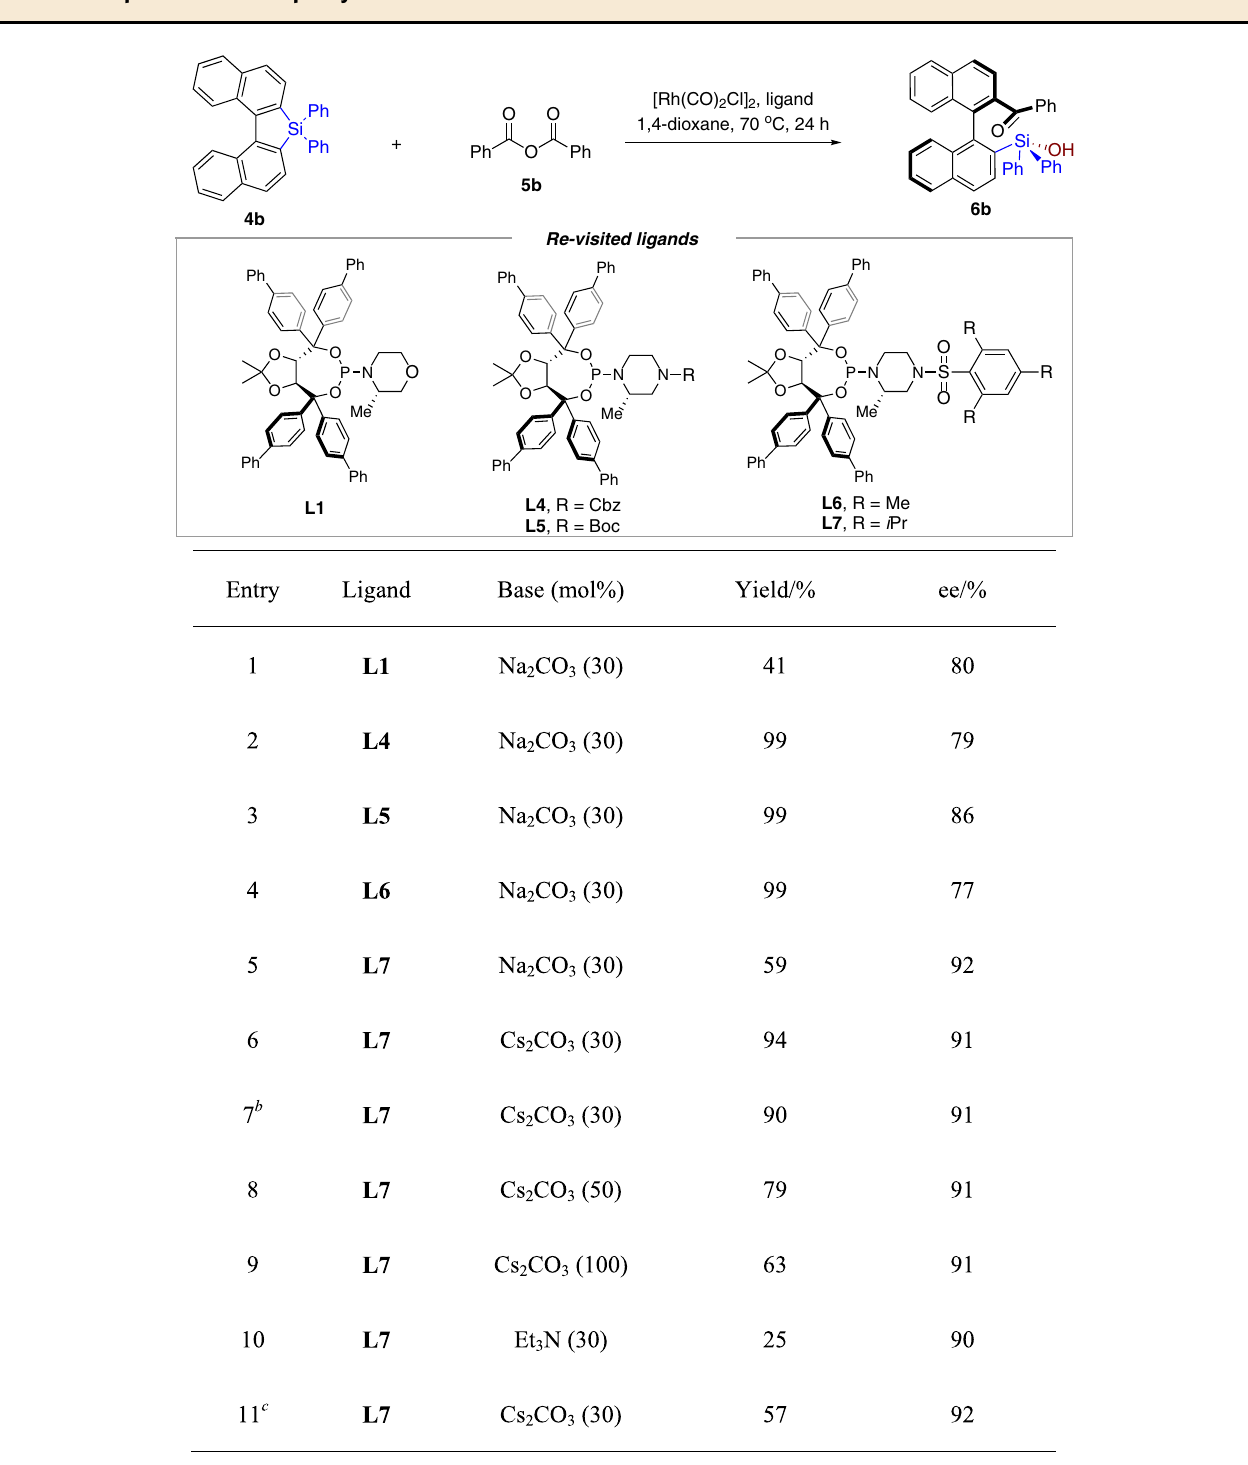
Table 2 Re-optimization for diphenylsila fl uorene a